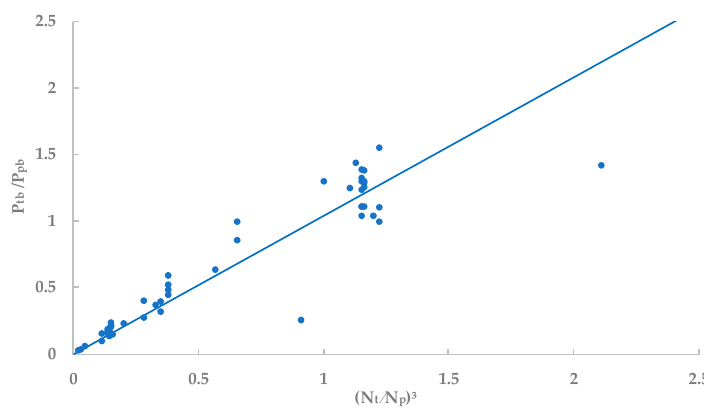
Figure 4. Correlation between P tb /P pb and N t /N p .